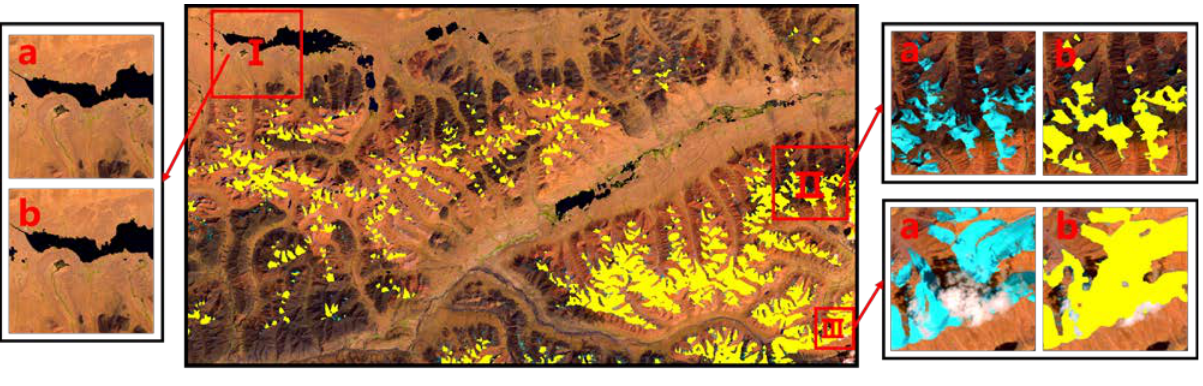
Figure 7. NDSI glacier identification result. (a): original image. (b): identification result